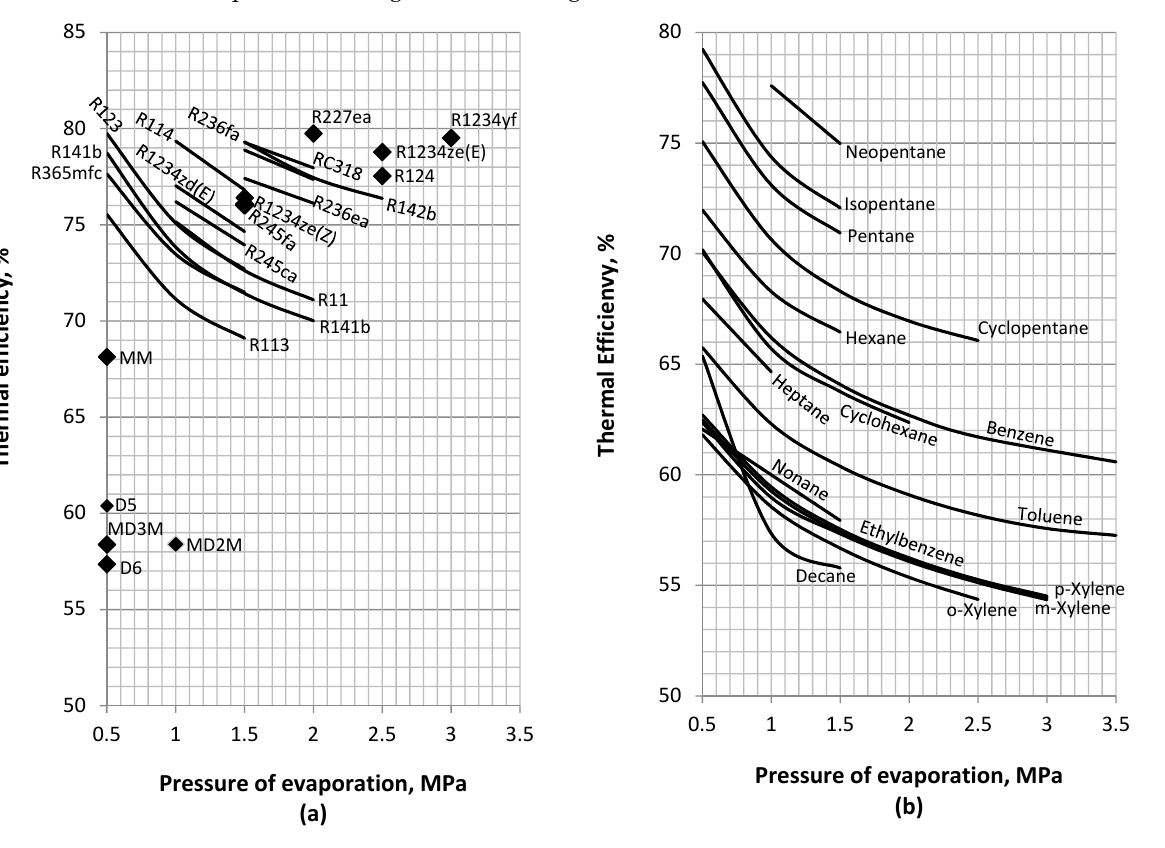
Figure 7. Effect of the evaporation pressure on the thermal efficiency of the ORC cycle using refrigerants and siloxanes ( a ) and hydrocarbon organic fluids ( b ).